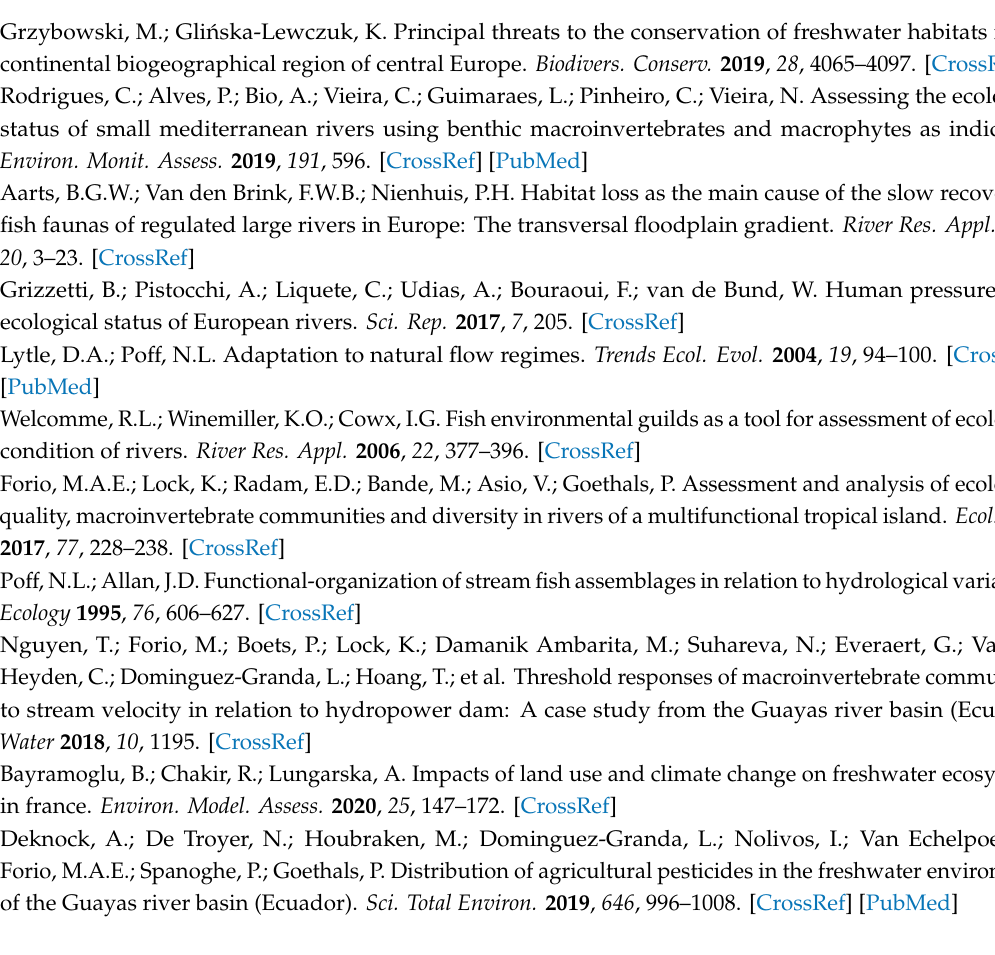
represented by grey lines, Table S1: Riparian attributes considered in the study, Table S2: Subjective scores for riparian attributes used to calculate an index of riparian condition, Table S3: Stream invertebrates found in the Zwalm River basin, Table S4: Terrestrial invertebrates found in the Zwalm River basin, Table S5: Overview of associations between each riparian attribute and diversity metric; Table S6: Spearman (cid:48) s rank correlation coe ffi cients of riparian attributes and other environmental